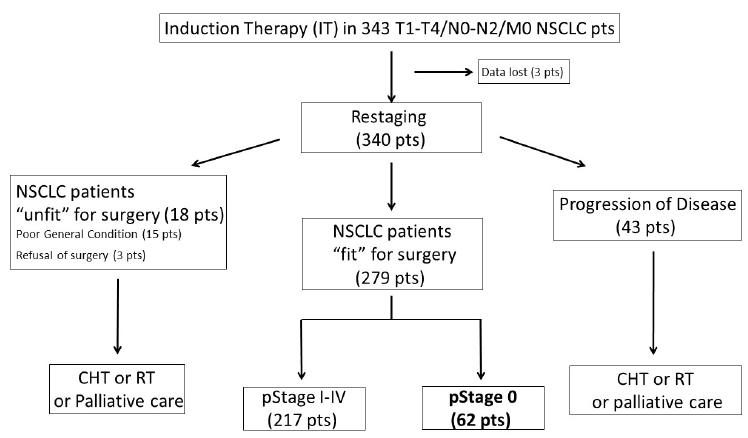
Figure 1. Consort-type diagram of the study group.